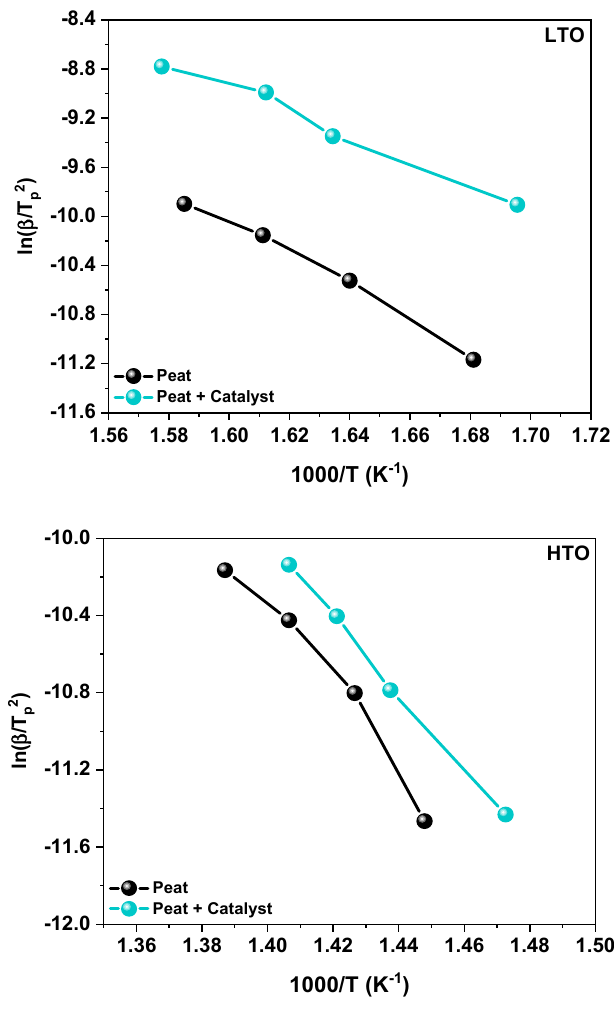
Figure 5. Kissinger’s plots for catalytic and non-catalytic peat oxidation.